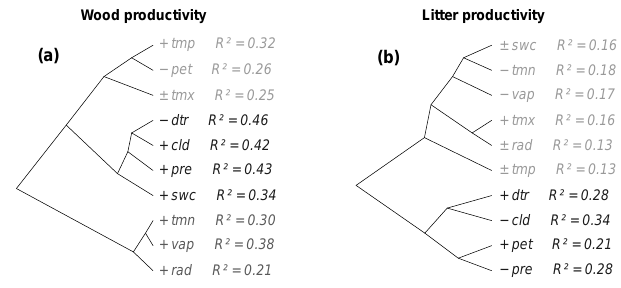
Figure 2. Dendrogram of the climate seasonality associations with the seasonality of wood productivity (a) and litterfall (b) . The global sign and R 2 of the linear relationship between wood and litter pro- ductivity and the following climate variable is given. + indicates a positive correlation between the climate variable and wood or lit- ter productivity in all the sites, – a negative correlation in all the sites, while ± indicates positive correlation for a portion of the sites while negative for the other. Climate variables in the same cluster are highly correlated, that is, they produce the same prediction in terms of values and effects for the same sites. Different shades of grey indicate the relative strength of associations for each cluster with seasonality of wood or litter productivity, black indicates the strongest association. cld: cloud cover; pre: precipitation; rad: solar radiation at the top of the atmosphere; tmp, tmn and tmx are re- spectively the daily mean, minimal and maximal temperatures; dtr: temperature amplitude; vap: vapour pressure; pet: potential evapo- transpiration; and swc: relative soil water